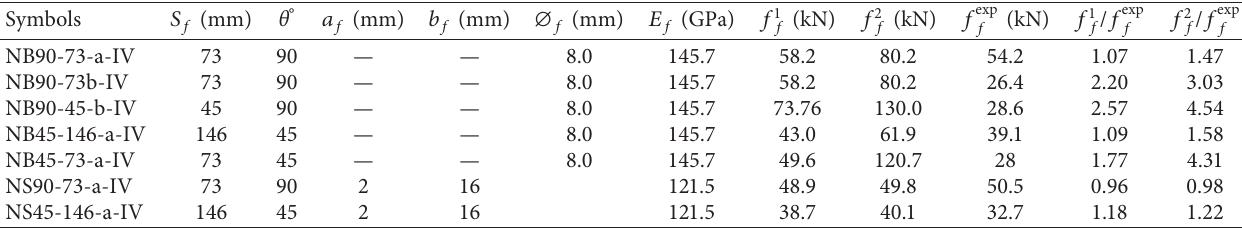
Table 4: Comparison between experimental results [26] and analytical results.